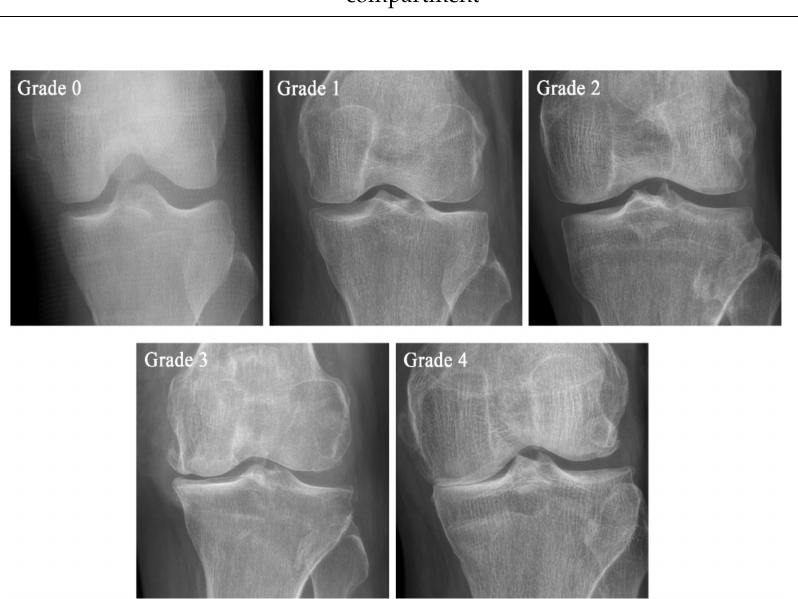
Figure 2. The example of the Kellgren–Lawrence (KL) scale. KL classification is the most widely used radiographic scale. The radiograph was recorded at St. Mary’s Hospital in